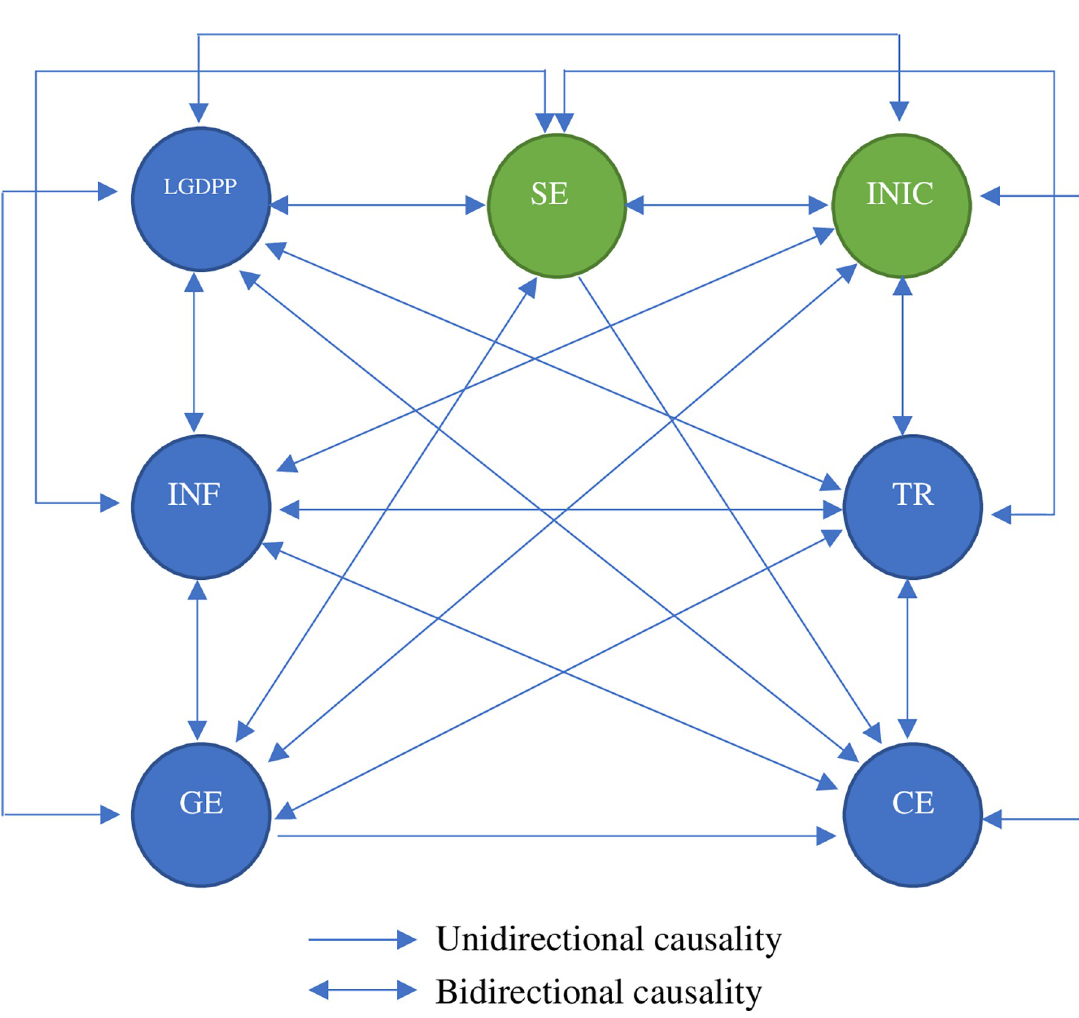
Fig 2. Causality relationship flows. Notes : SE: Shadow economy; INIC: Index of national intellectual capital; LGDPP: GDP per capita; TR : trade openness; CE: Bank credit; GE : Government expenditure; INF : Inflation.